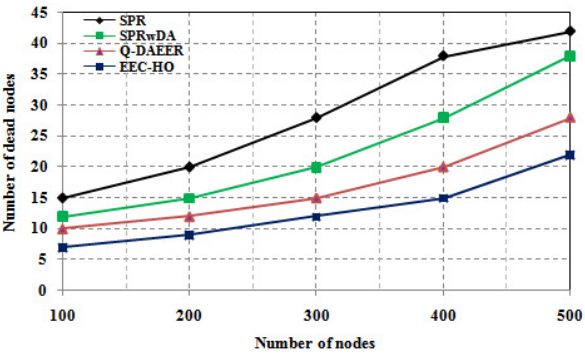
Figure 8. Network lifetime with number of simulation rounds